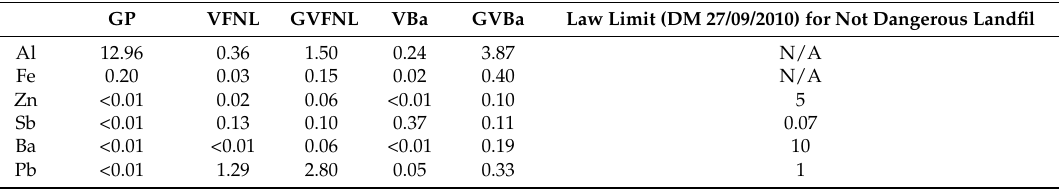
Table 2. Leaching test results (expressed in mg/L) of geopolymers aged 28 days containing glasses compared to pure metakaolin geopolymer (GP) and pure glasses (VBa and